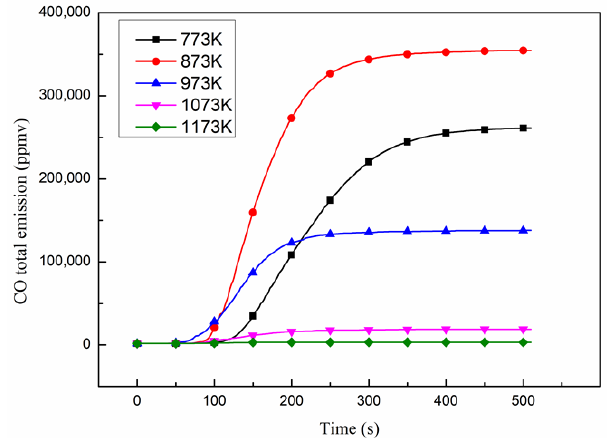
Figure 3. The e ff ect of combustion temperature on CO total emission. Figure 3. The effect of combustion temperature on CO total emission. Table 2. The e ff ect of combustion temperature on CO